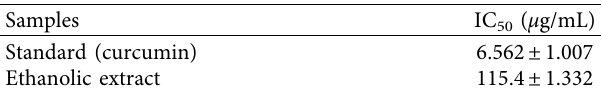
Table 2: Cytotoxicity of the ethanol extract of C. nioroense and curcumin expressed as IC 50